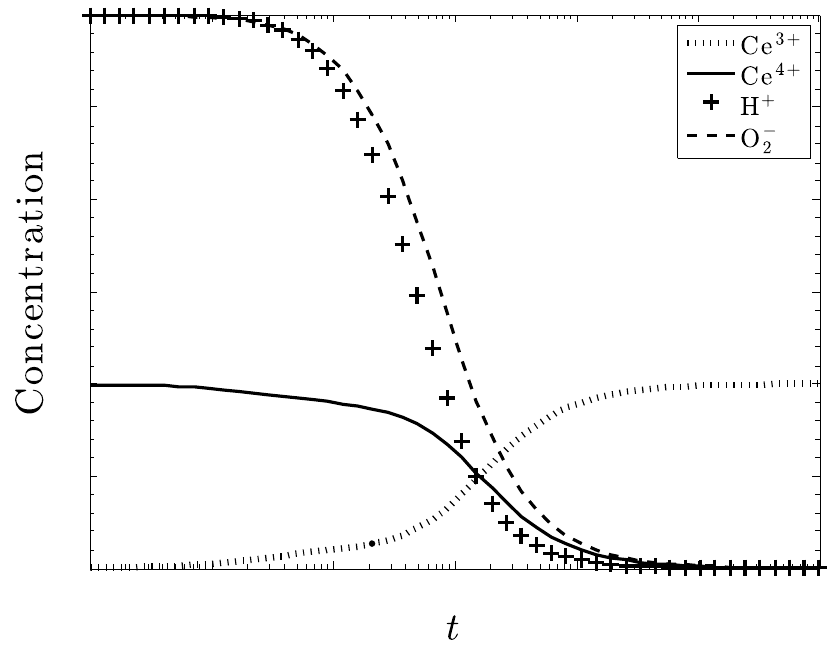
Figure 8. The concentration of superoxide ions is three times the concentration of ceria, now all in the +4 state. The concentration of superoxide is now well controlled.